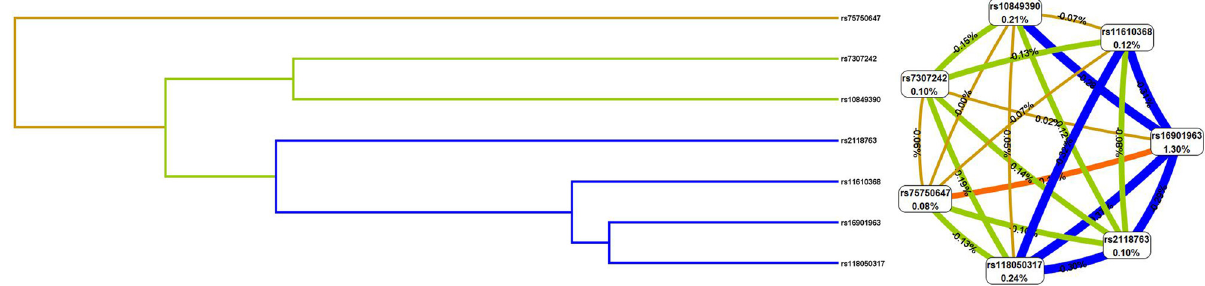
Figure 1: Potential SNP – SNP interactions for predicting the risk of lung cancer risk by MDR